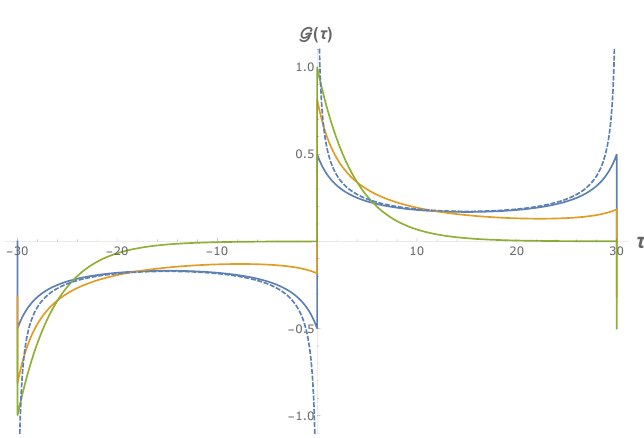
Figure 1. Thermal propagators at (cid:12) = 30 in the chaotic phase and integrable phase. The blue curve is for (cid:22) = 0 in highly chaotic state. The dashed blue line is the conformal limit. The orange curve is for (cid:22) = 0 : 27 again in the chaotic state. The green curve is for the same (cid:22) = 0 : 27 but in the integrable state. Note that we have chosen the inverse temperature (cid:12) = 30 to highlight the contrast between the chaotic and the integrable phase. Moreover for (cid:22) = 0 : 27, (cid:12) = 30 is close to the critical point where the grand potentials in both the chaotic and integrable phase are almost equal (see (cid:12)gure